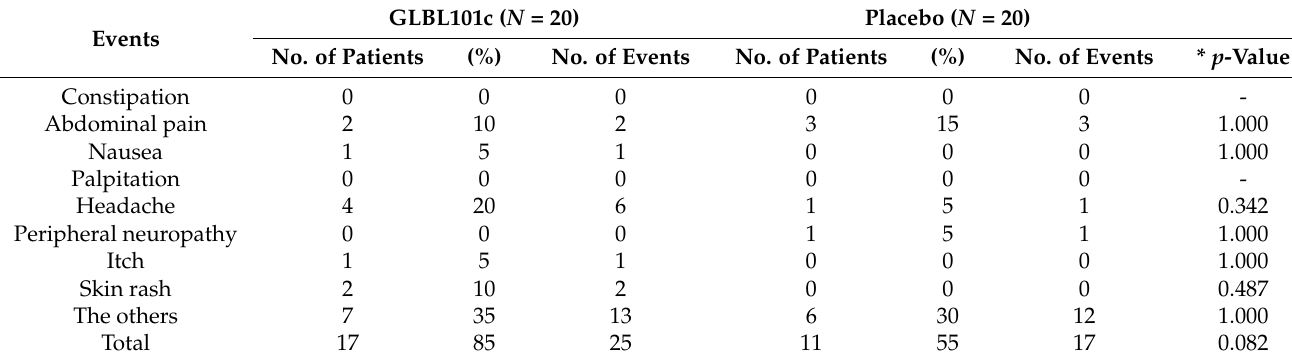
Table 2. Adverse events.